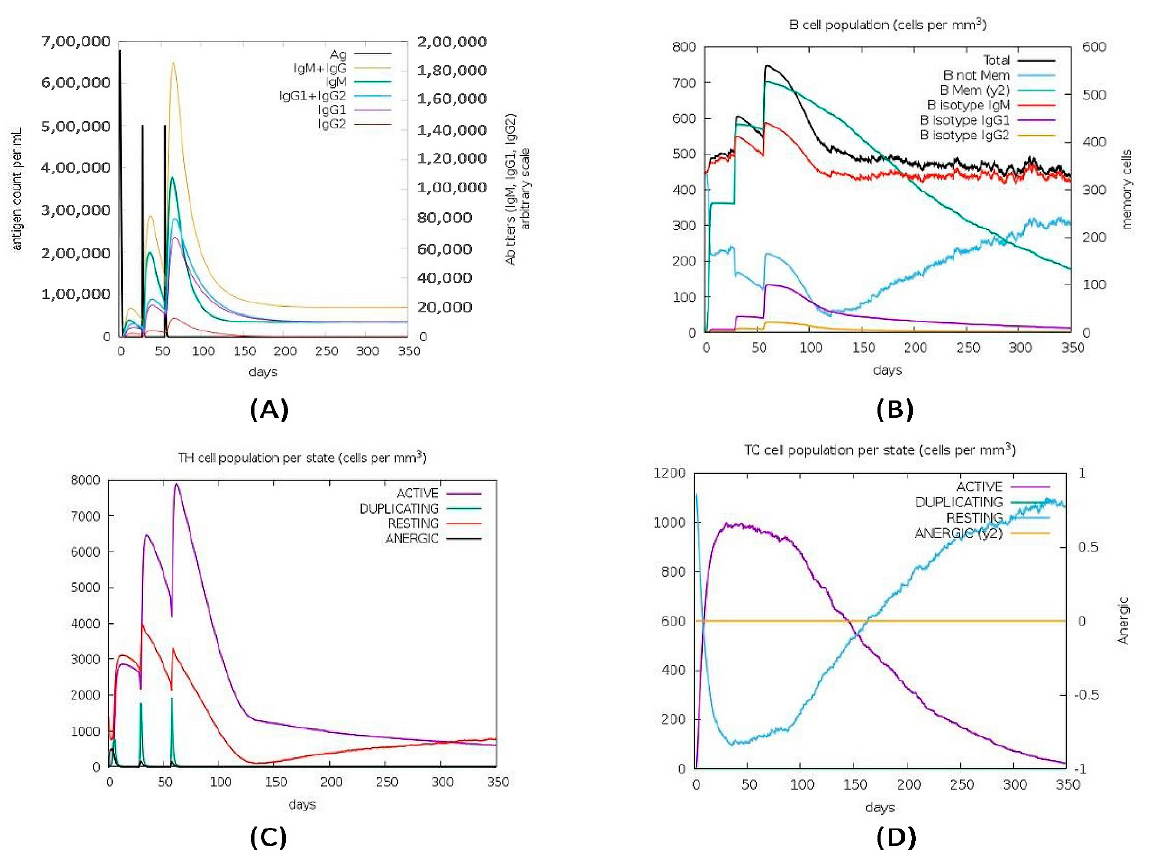
Figure 9. The immune simulation results of the designed vaccine construct using a C—immsim server: ( A ) Depicts increase in Immunoglobulins production in response to exposure to antigen injections with a marked decrease in the antigen concentration; ( B ) Showed the B—cell populations with a marked increase in the memory and non-memory immunoglobulins; ( C , D ) Indicates increased levels in the populations of the active T-helper and T-cytotoxic cells per state after the injections, respectively. The resting state indicates cells not exposed to antigen while the anergic state indicates tolerance of the T- cells to the antigen exposures.